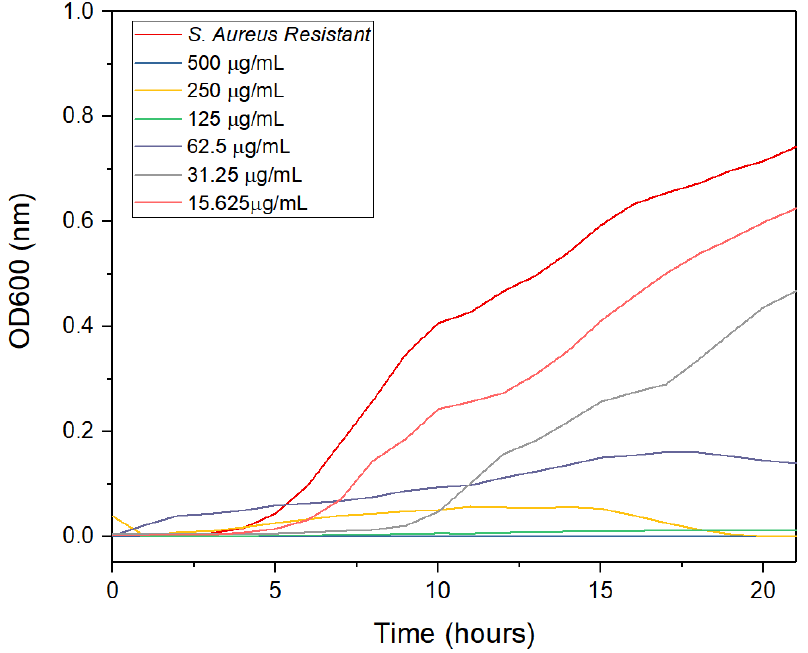
Figure 12. Antimicrobial activity of the AgNPs synthesized with orange peel extract at different times.